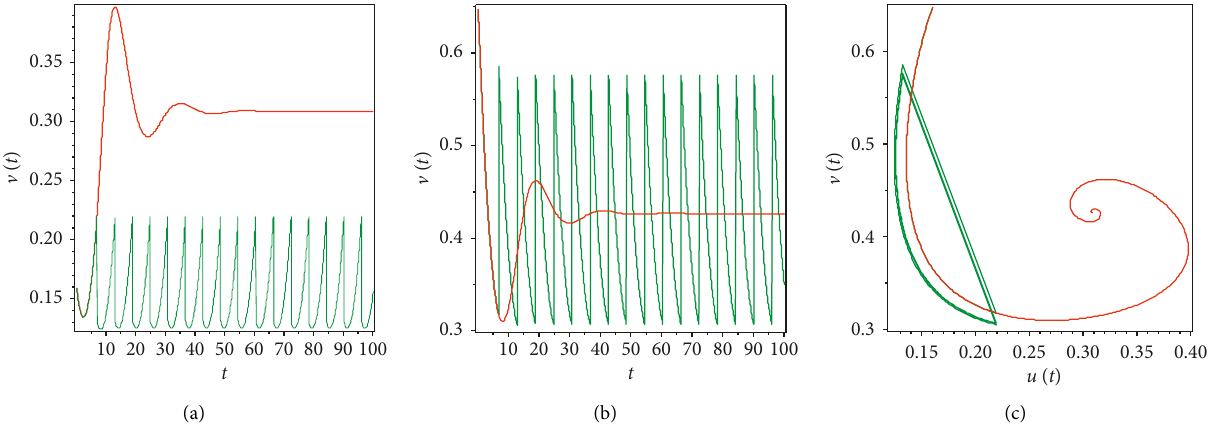
� 1, k � 0 . 2, TH � 0 . 6, τ � 0 . 3, and D � 0 . 5. 1 2